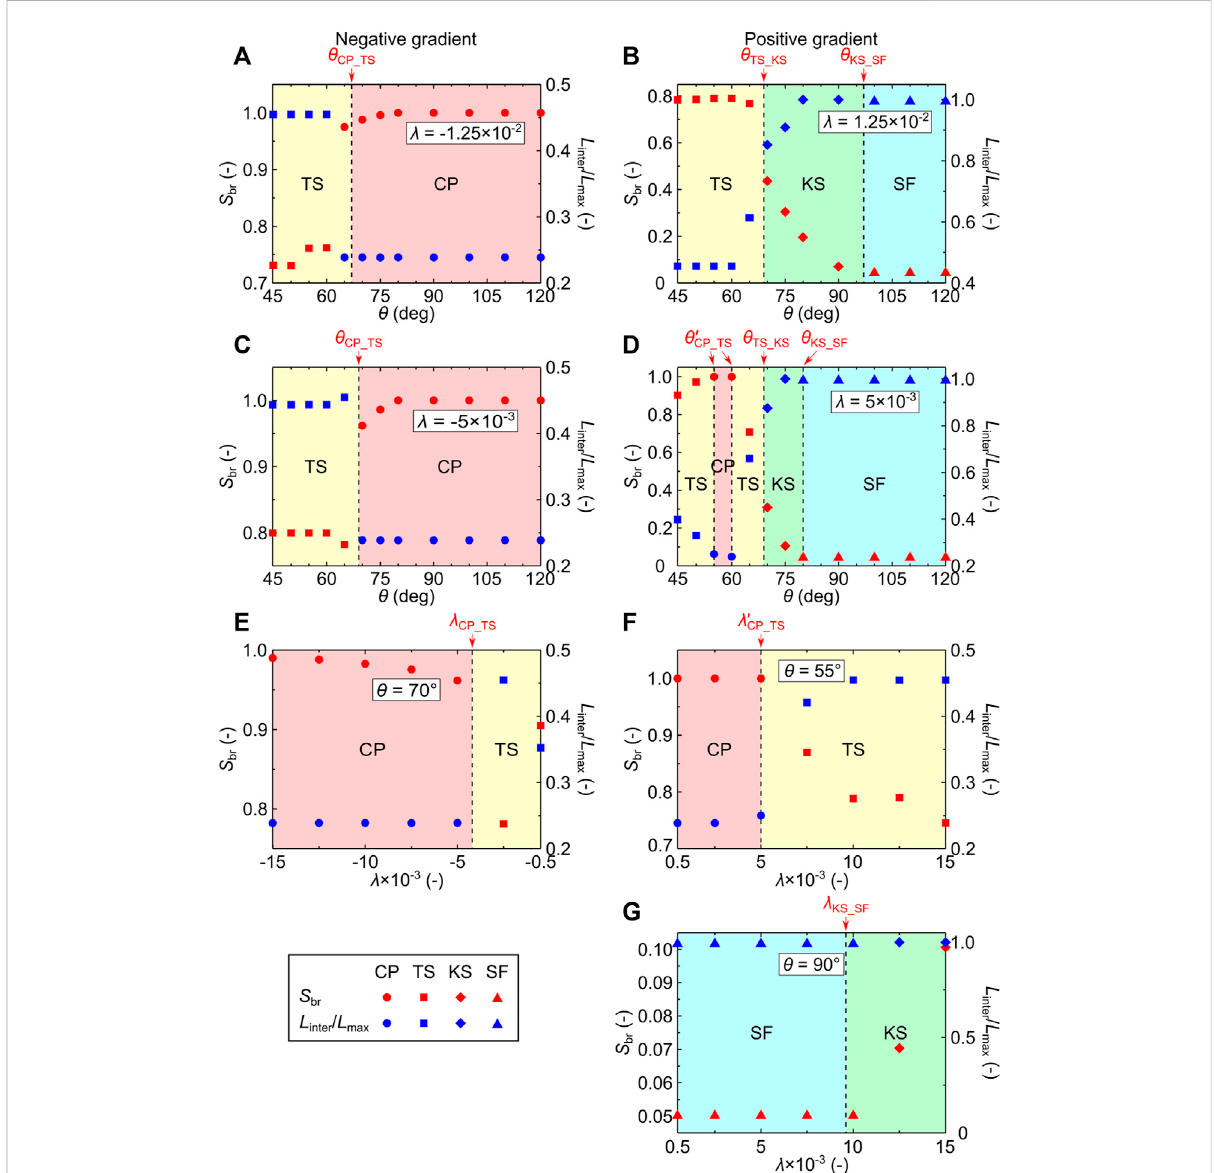
FIGURE 11 Variationsofsaturation S br (reddots)andnormalized fl uid – fl uidinterface L inter / L max (bluedots)with θ at| λ | =1.25×10 – 2 (A,B) and5×10 – 4 (C,D) , and with λ at θ = 70 ° (E) , 55 ° (F) , and 90 ° (G) . The dots of circles, squares, diamonds, and triangles denote thedisplacement patterns of CP, TS, KS, and SF, respectively, in Figure 9 and Supplementary Figures S4, S5. The vertical dashed lines denote the boundaries separating different displacement patterns predicted by the theoretical models, and the areas with red, yellow, green, and blue represent the predicted displacement patterns of CP, TS, KS, and SF,